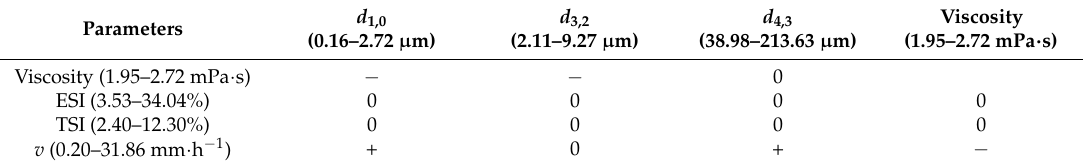
Table 2. Results obtained for Spearman’s correlation between the parameters of the particle size distribution of the dispersed phase (Sauter diameter d 3,2 , De Brouckere diameter d 4,3 , and the number mean diameter d 1,0 ); parameters of suspension stability (Turbiscan stability index (TSI), emulsion stability index (ESI), flotation rate v ); and viscosity of the continuous phase. Positive correlation ( p < 0.05, Spearman’s rank correlation coefficient > 0) is marked by “+”, negative correlation ( p < 0.05, Spearman’s rank correlation coefficient < 0) is marked by “ − ”, no significant correlation is marked by “0” ( p >